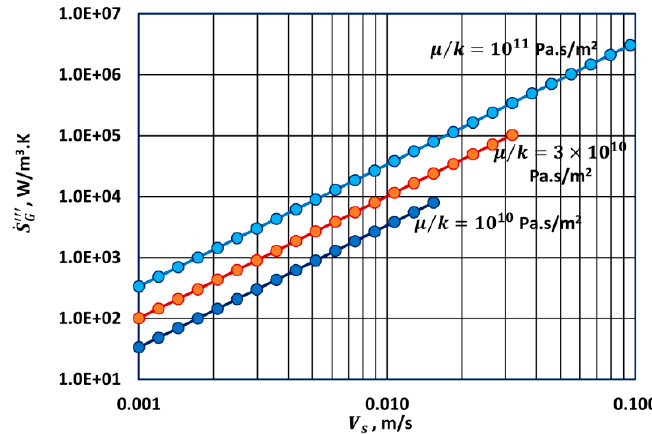
Figure 18. E ff ect of viscosity to permeability ratio ( µ / k ) on the rate of entropy generation per unit Figure 18. Effect of viscosity to permeability ratio ( (cid:2020) (cid:1863)⁄ ) on the rate of entropy generation per unit volume of consolidated porous medium in laminar flow ( T = 298.15 K, β = 10 8 m − 1 , ρ = 10 3 kg / m 3 ). volume of consolidated porous medium in laminar flow ( (cid:1846) = 298.15 K, (cid:2010) = 10 8 m − 1 , (cid:2025) = 10 3 kg/m 3 ). The data points are generated using Equation The data points are generated using Equation (65).